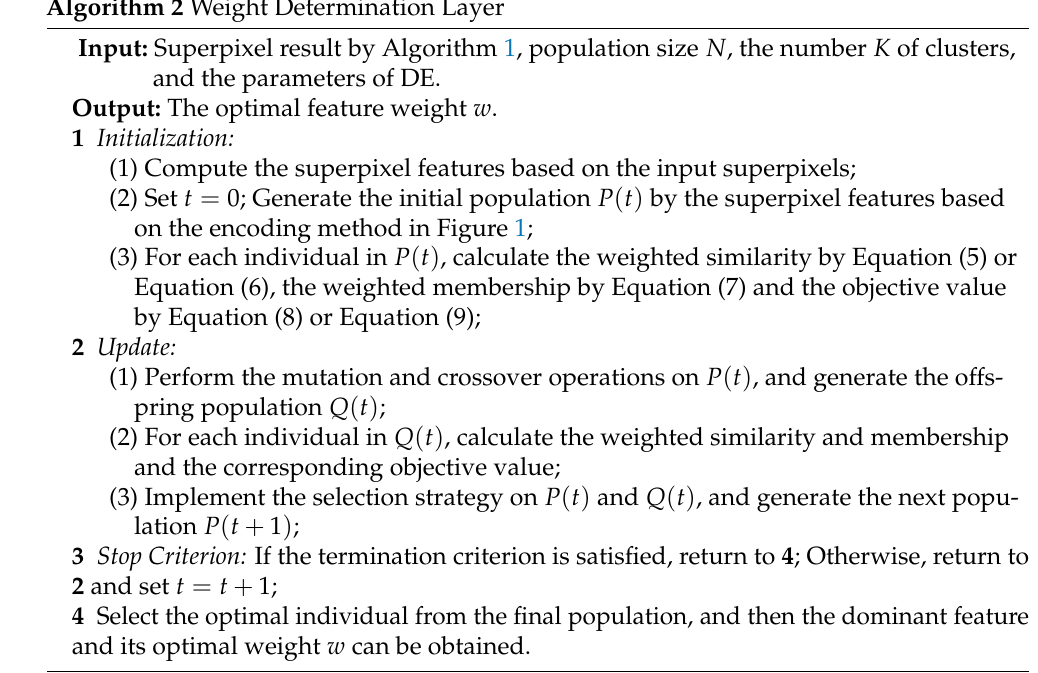
Algorithm 2 Weight Determination